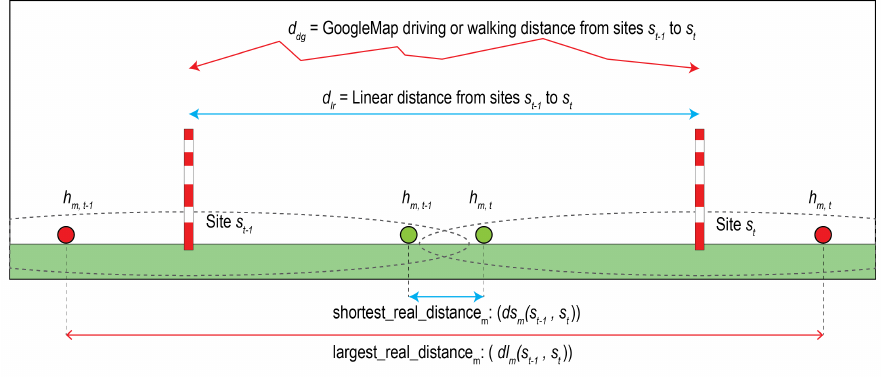
Figure 8. The minimum velocity solution